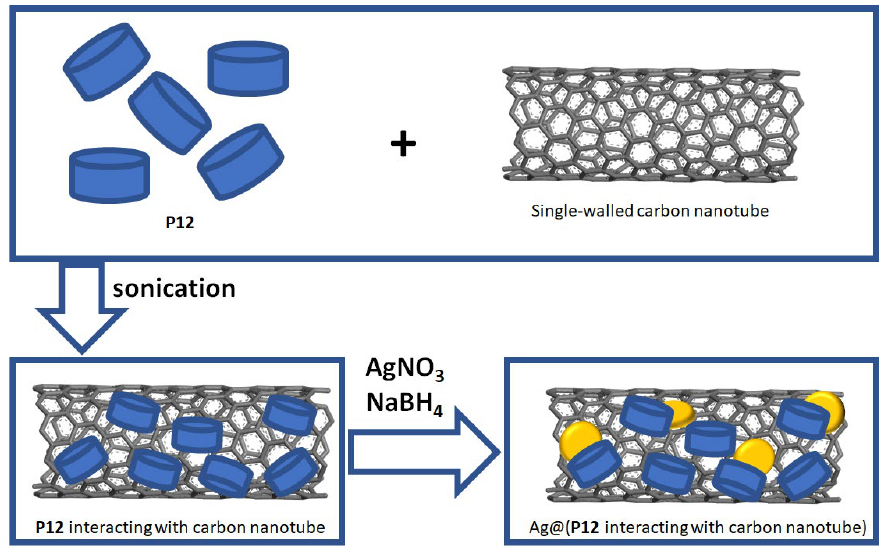
Figure 4. Illustration of the fabrication of hybrid materials Ag@( P12 non-covalently interacting with carbon nanotubes) [86].